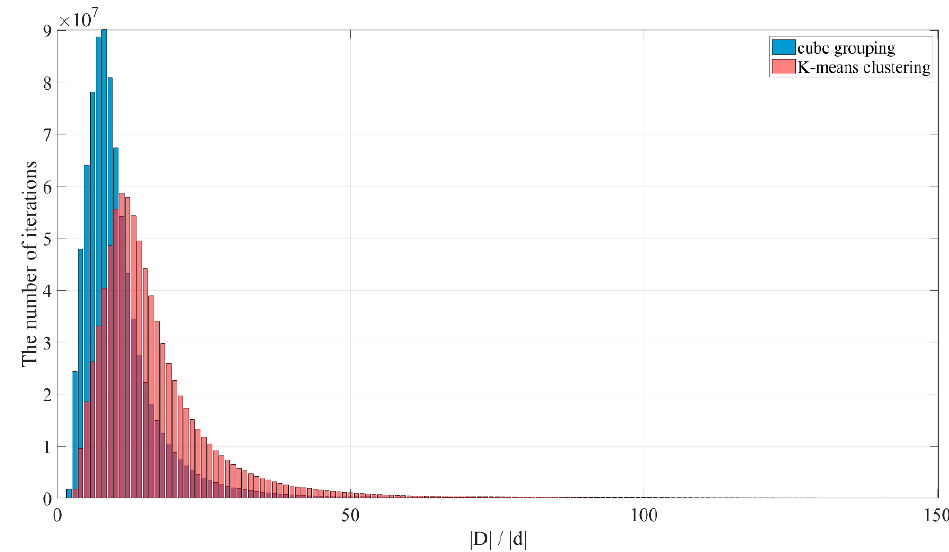
Figure 4. Histogram of the ratio | D | to | d | for each basis to basis interaction in canonical 3 m sphere CAD model.